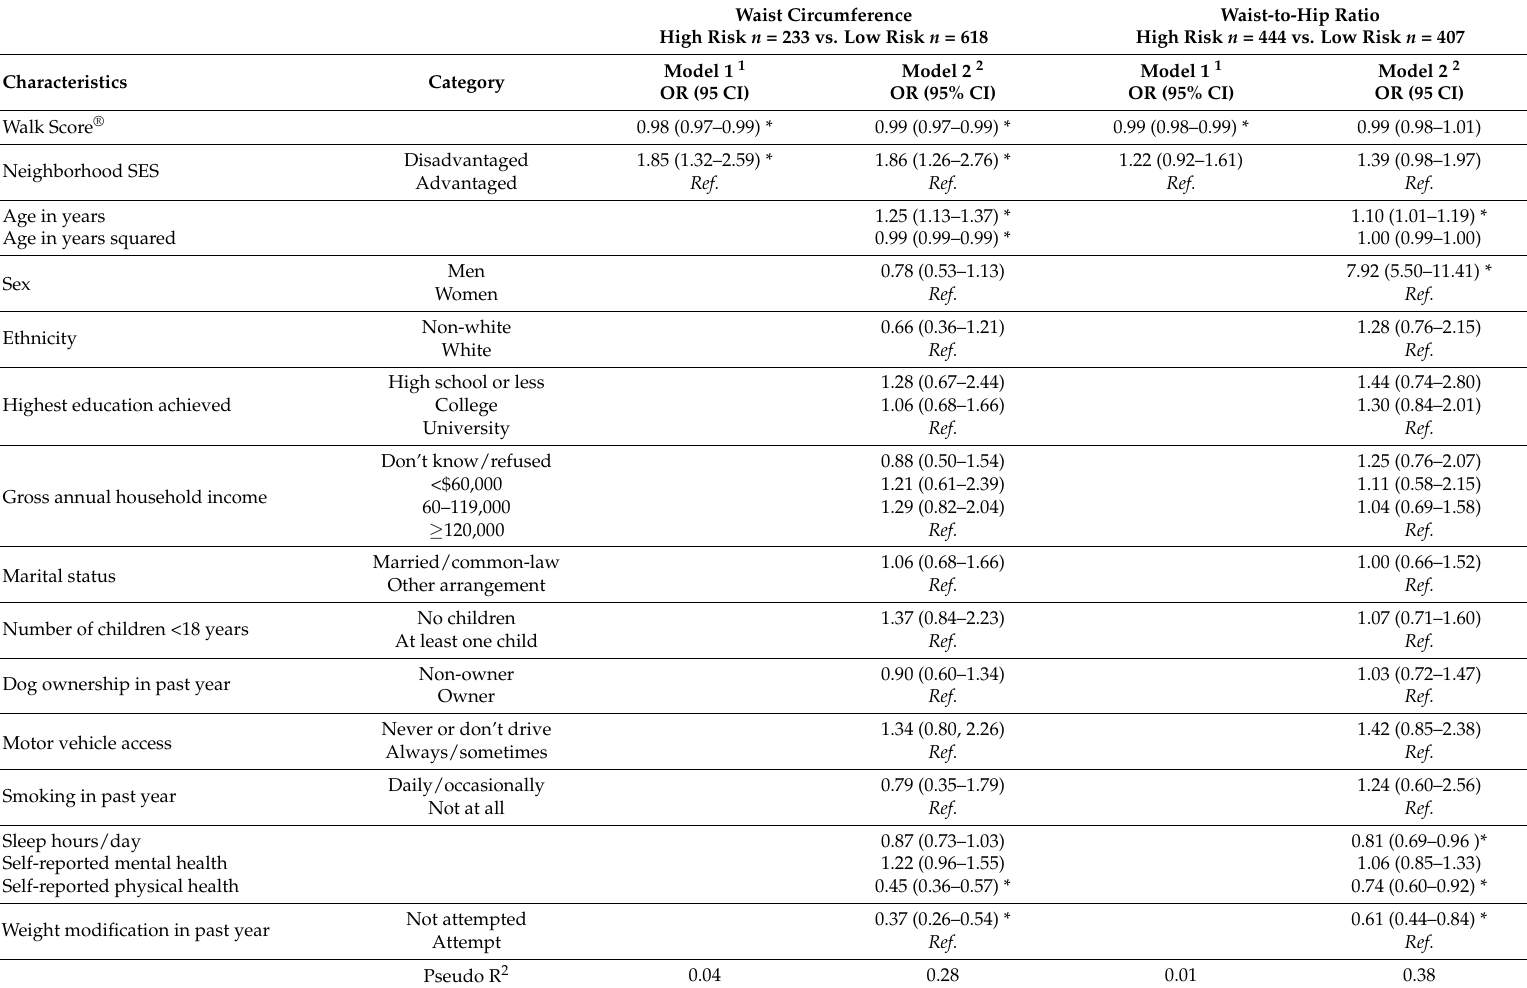
Table 2. Association between (1) waist circumference and (2) waist-to-hip ratio, and neighborhood, sociodemographic, and health